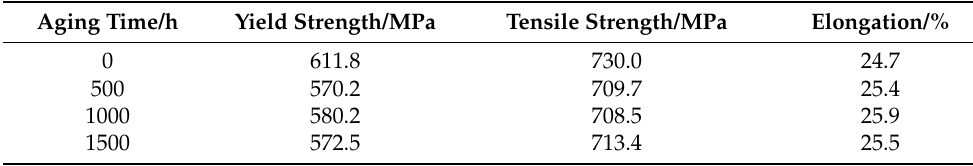
Table 6. Mechanical properties of aged 0.004ZrH steel.